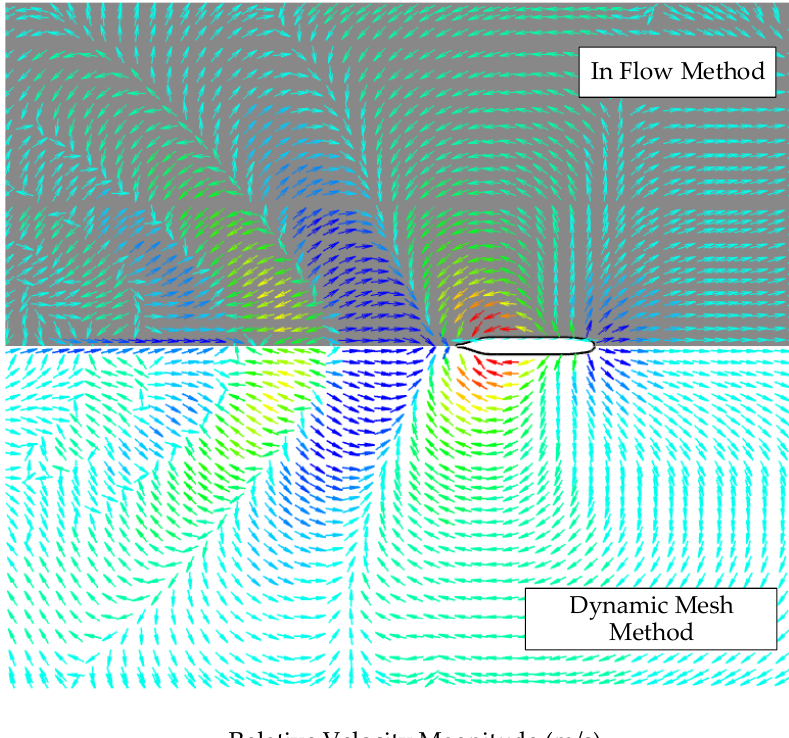
Figure 6. Velocity vector field at z = 0 with the two methods.